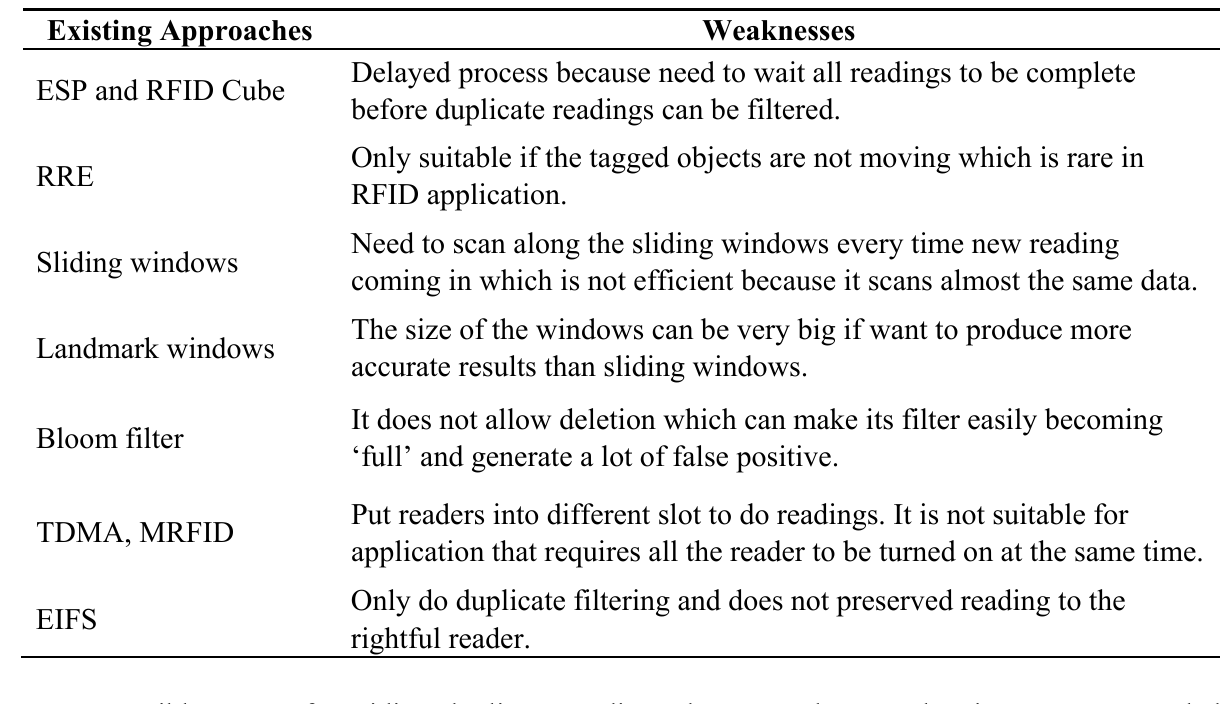
Table 1. Summary of existing duplicate RFID data filtering